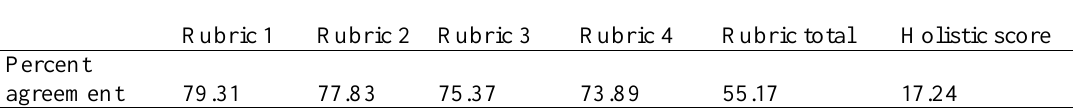
Percent Agreement between Instructor and AES-Scores – Pharmacy